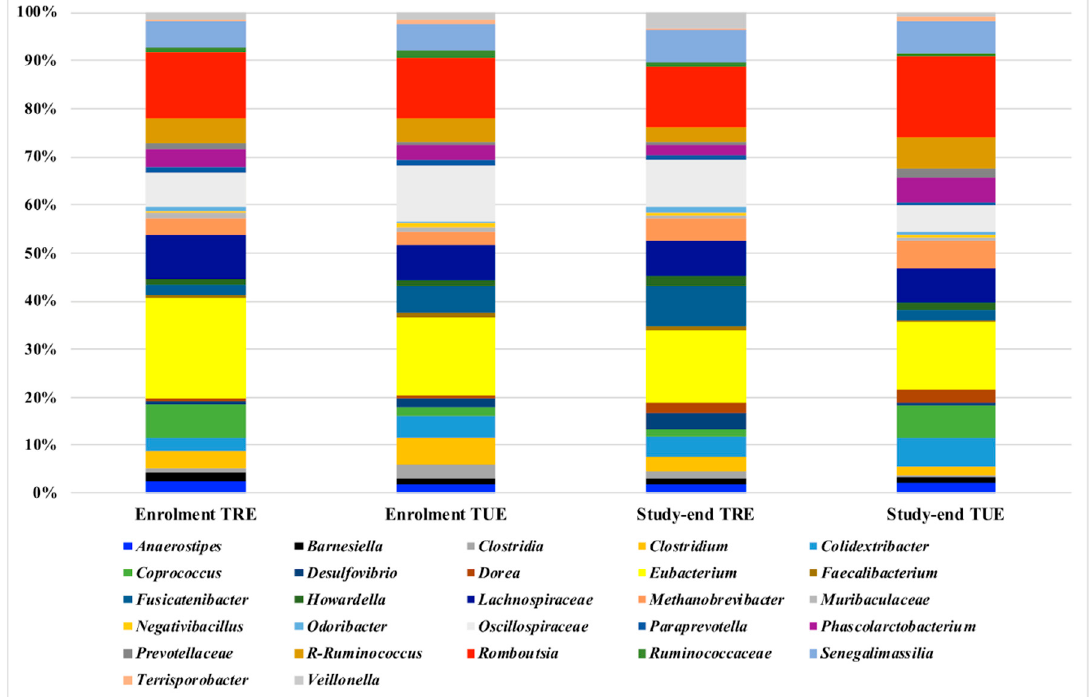
Figure 1. Microbiota composition detected by 16S amplicon-target sequencing. Only ASVs with a frequency of 100 in at least 20 samples are shown. Frequency of ASVs in the 4 study groups (TRE enrollment, TRE study end, TUE enrollment, TUE study end) were shown.